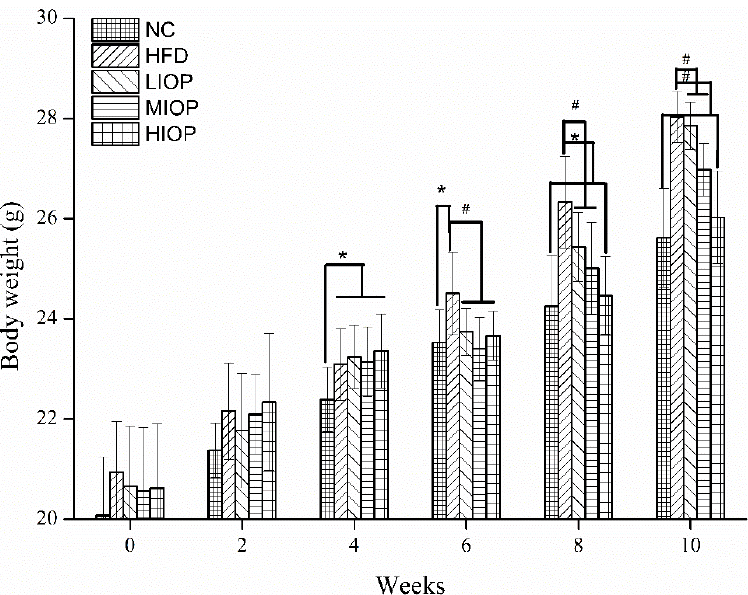
Figure 5. Effects of IOP on the body weight of mice. The data are represented as mean ± SD ( n = 8). * p < 0.05, versus the NC group; # p < 0.05, versus the HFD